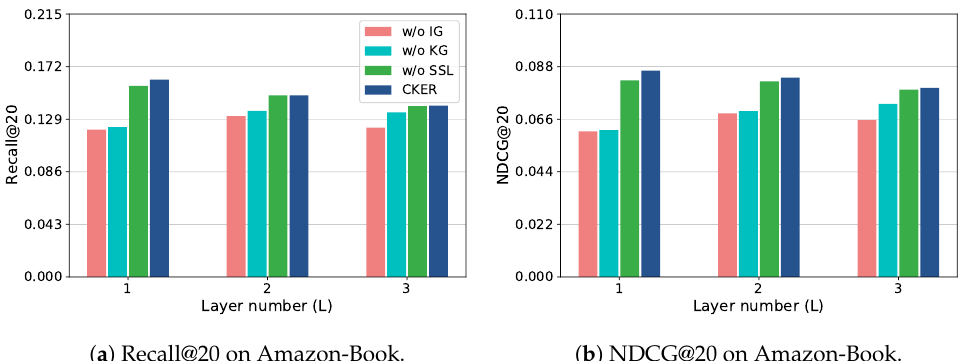
Figure 3. Impact of graph convolution layer